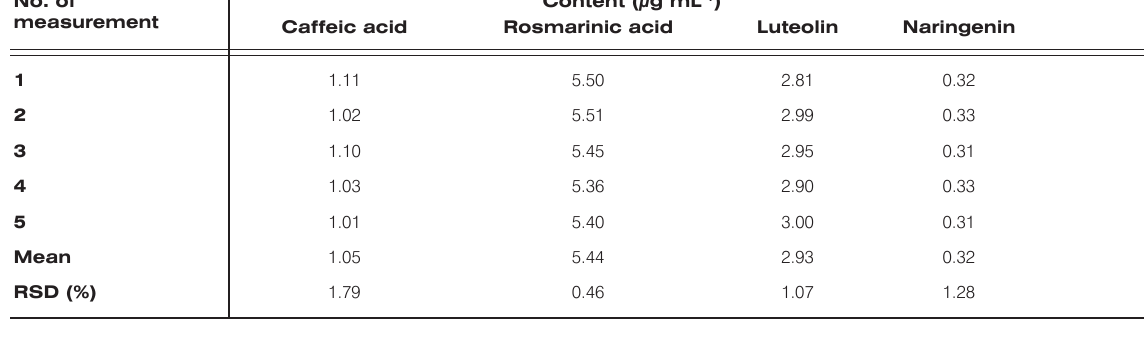
Table 3. Repeatability of determination of polyphenolic compounds in control plant extract of Satureja hortensis L. No. of measurement